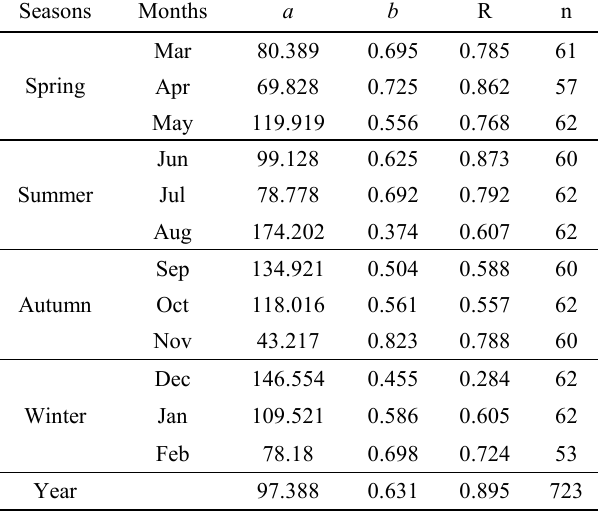
Table 2. Regression coefficients of atmospheric weighted average temperature in